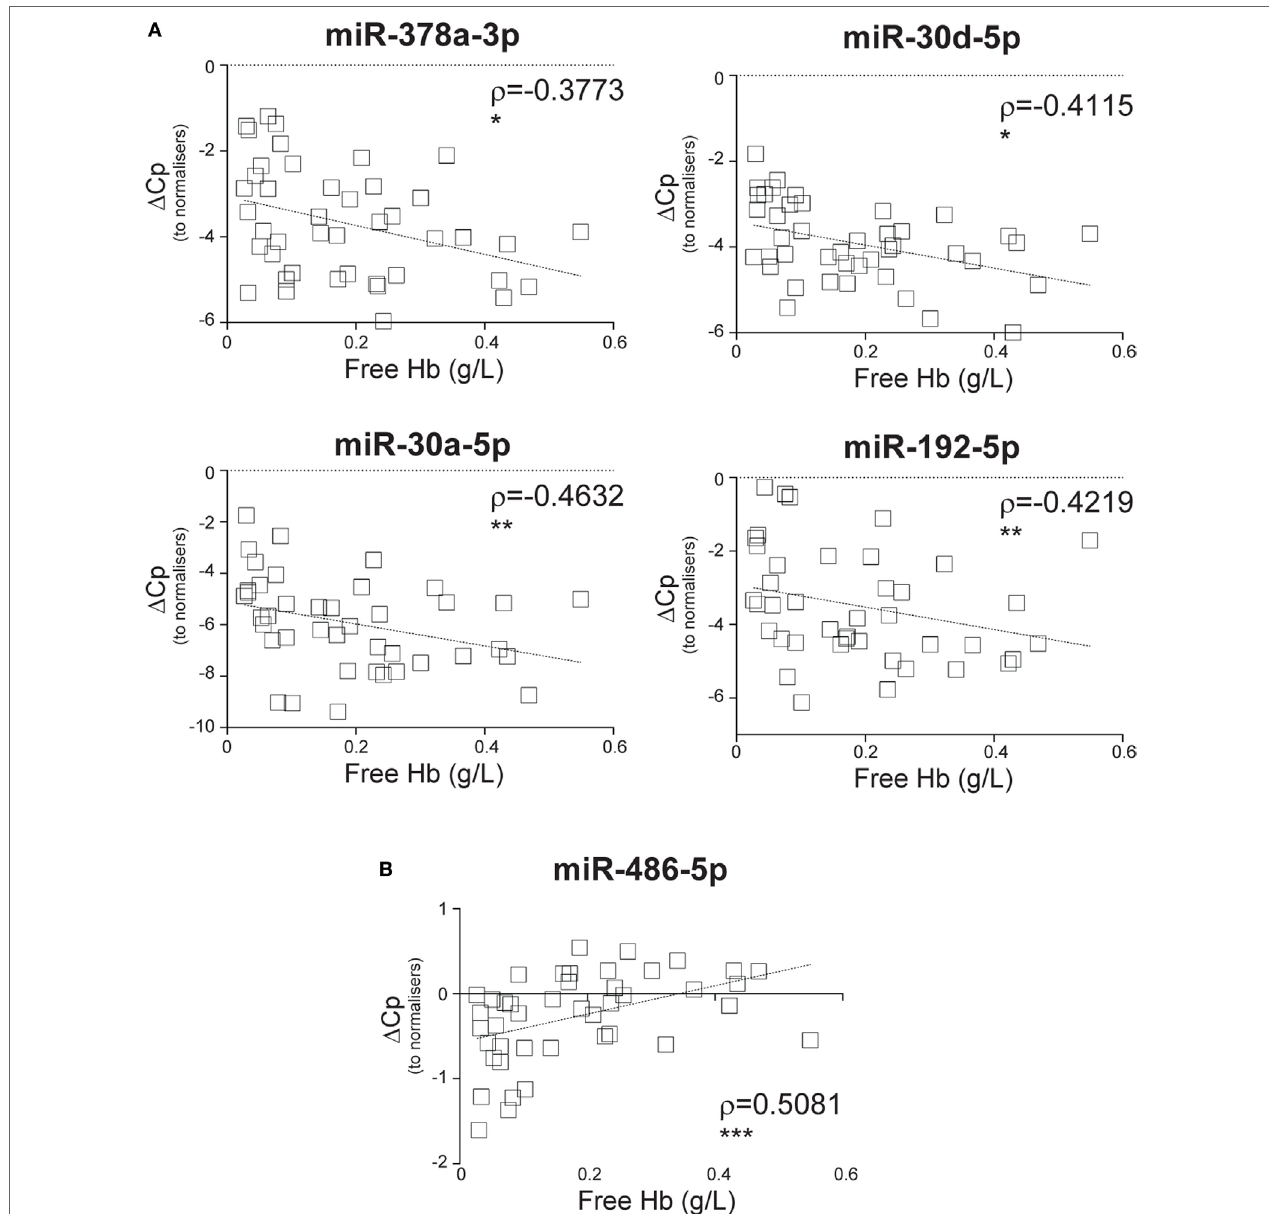
FigUre 4 | Circulating inflammatory-relevant microRNA levels inversely correlate with markers of red-blood cell lysis. In miRNA qPCR arrays, within each patient’s specimen, crossing point (Cp) of individual miRNAs (open squares) were normalized as in Figure 1 and analyzed in correlation with levels of free Hb, which is derived from the lysis of red blood cells. Each square represents an individual patient. Correlation trends are shown with the linear regression model including Spearman rho ( ρ ) and the significances of the correlations (* p ≤ 0.05; ** p ≤ 0.005; and *** p ≤ 0.0005 or ns, non-significant) for (a) miR-378a-3p, miR-30a-5p, miR-30d-5p, and miR-192-5p and (B) miR-486-5p in non-infective systemic inflammatory response syndrome patients ( n =